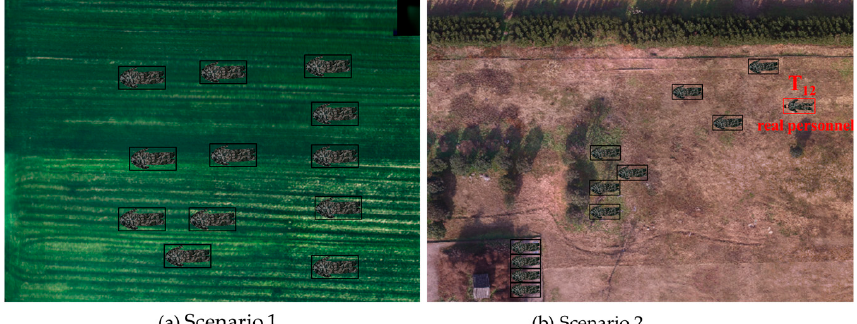
Figure 10. Illustration of experimental settings for two scenarios. ( a ) Scenario 1 : 12 sets of green camouflage clothes in a homogeneous grassland background, ( b ) 11 sets of green camouflage clothes, and one real personnel in green camouflage clothing in a complex background.